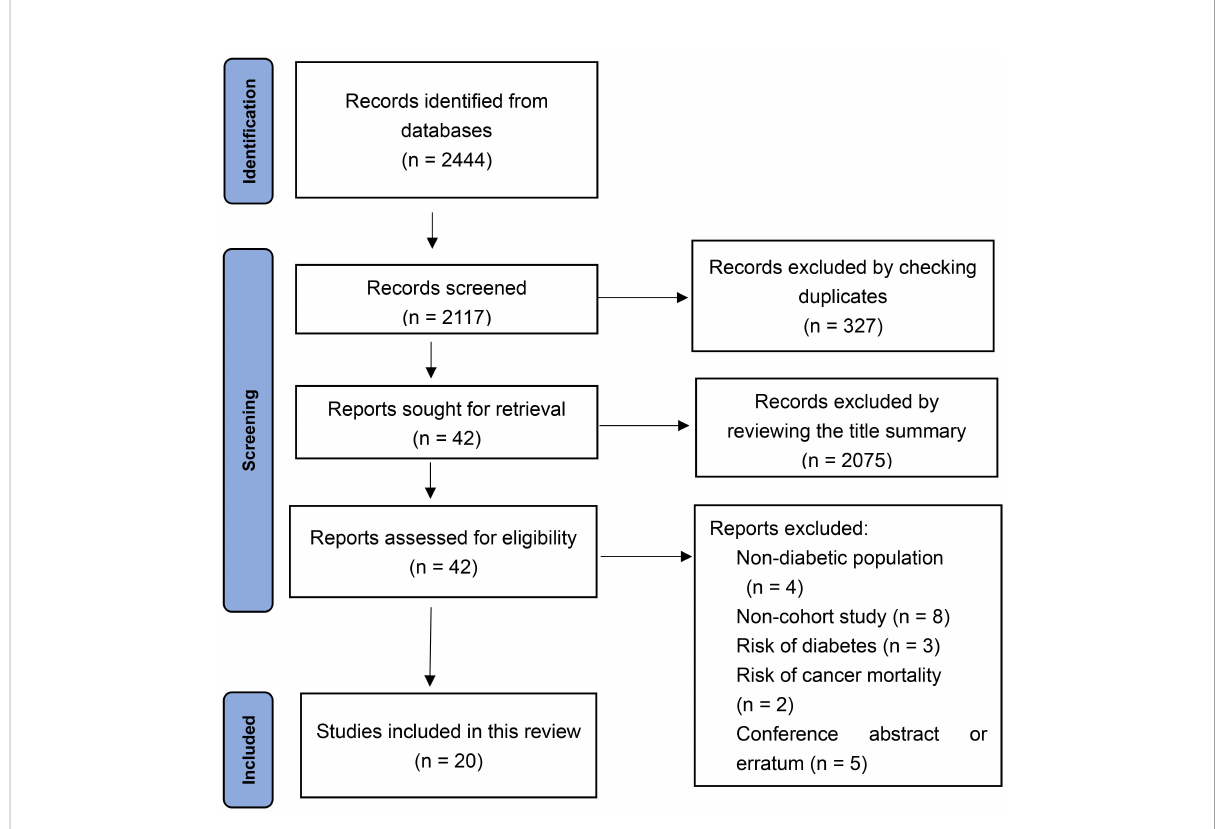
FIGURE 1 Flowchart of study